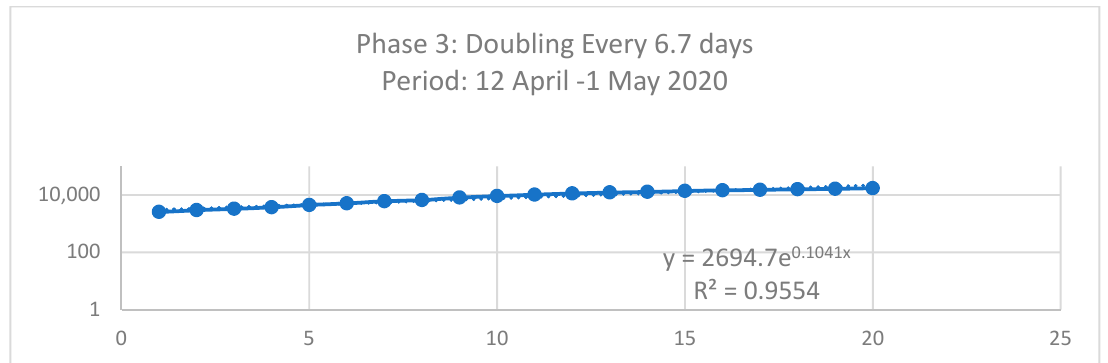
Figure A2. Logarithmic scale. Doubling time calculated based on a 20-day period in Phase 2. Data retrieved from the Singapore Ministry of Health and the WHO [68,69]. Last updated on 1 May 2020.